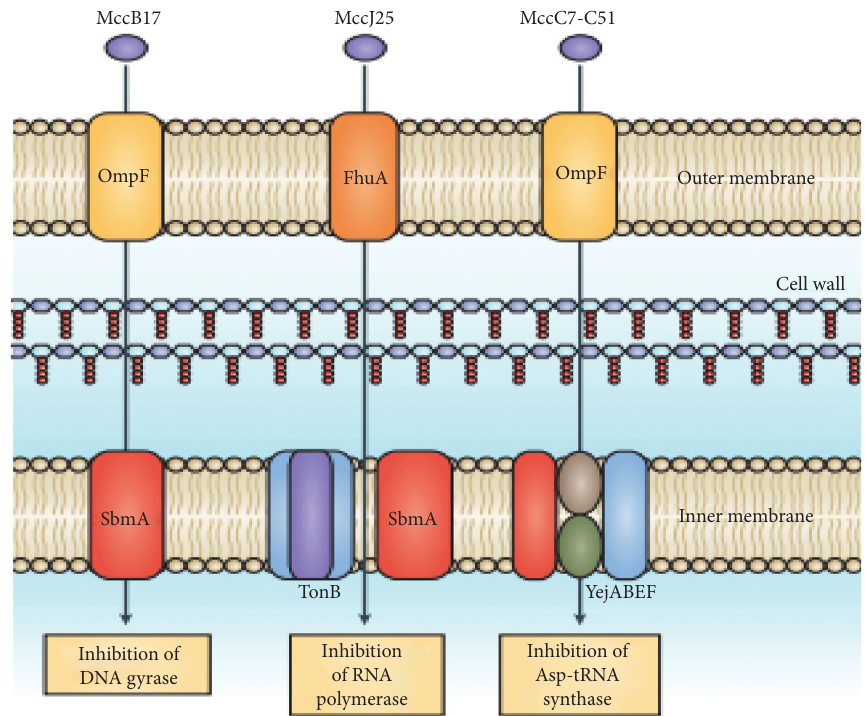
Figure 2: Mechanism of action of bacteriocins on Gram-negative bacteria